Question: Write the caption for this figure.
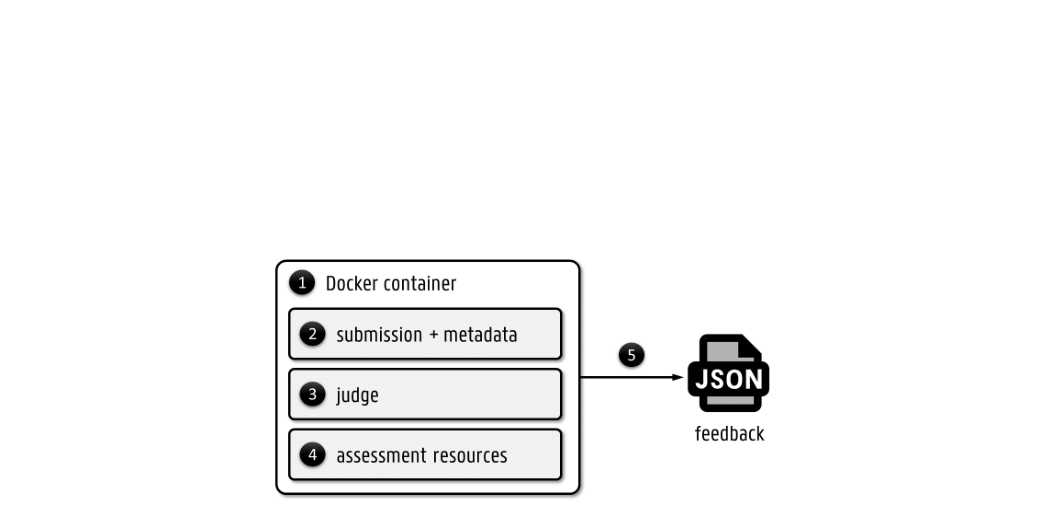
Answer: Outline of the procedure to automatically assess a student submission for a programming assignment. Dodona instantiates a Docker container (1) from the image linked to the assignment (or from the default image linked to the judge of the assignment) and loads the submission and its metadata (2), the judge linked to the assignment (3) and the assessment resources of the assignment (4) into the container. Dodona then launches the actual assessment, collects and bundles the generated feedback (5), and stores it into a database along with the submission and its metadata.